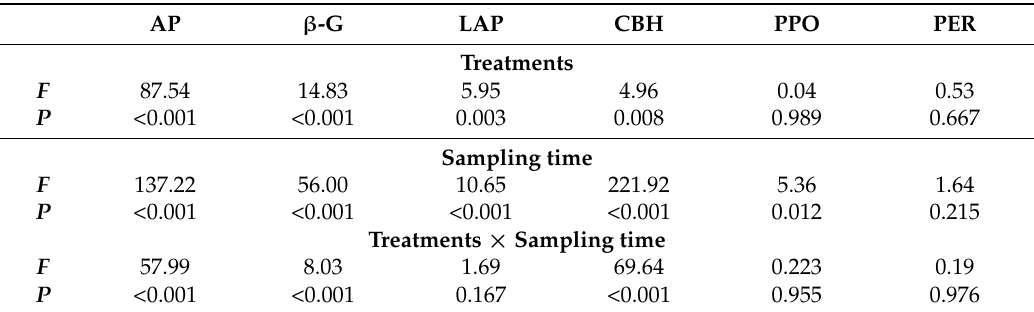
Table A1. Two-way ANOVA of the different treatments and sampling time on potential extracellular enzyme activities.